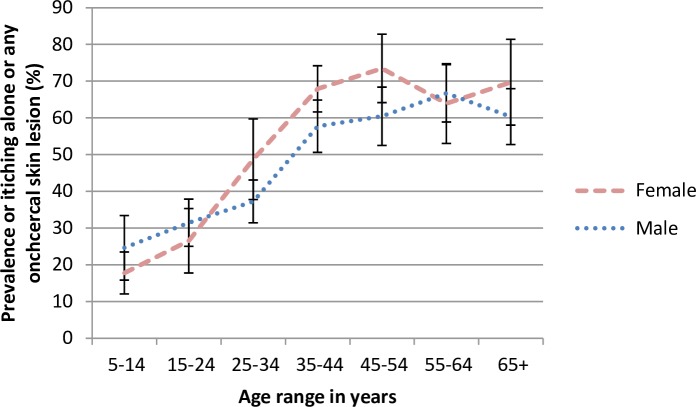
Age and gender-specific prevalence of itching alone or any onchocercal skin disease including nodules in endemic savanna communities, Kaduna State, Northern Nigeria.Error bars represent mean and 95% CI.